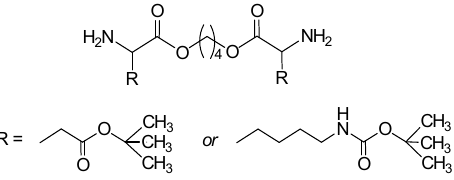
Figure 22. AAAD monomers derivatives of β - C protected and ε - N protected lysine.